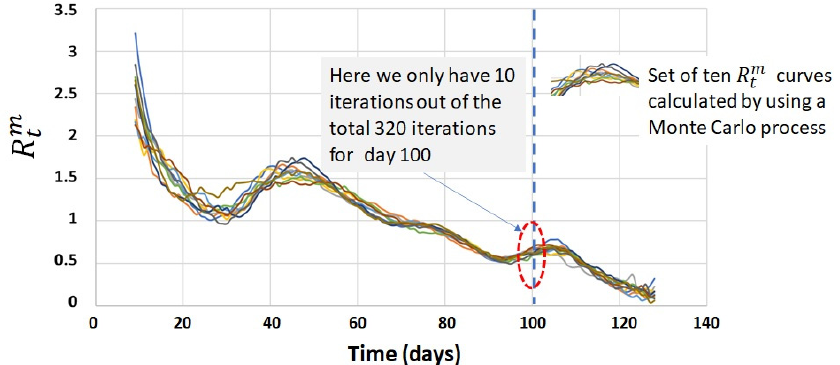
Figure 5. Superposition of 10 randomly generated 𝑅 (cid:3047)(cid:3040) curves. Each 𝑅 (cid:3047)(cid:3040) curve was generated on calculus based on a specific 𝐼𝑚 (cid:3047) series and applying (19). Following a Monte Carlo simulation process, the 𝐼𝑚 (cid:3047) series were calculated with the 𝐼 (cid:3047) series data generated by a random incidence series generator.